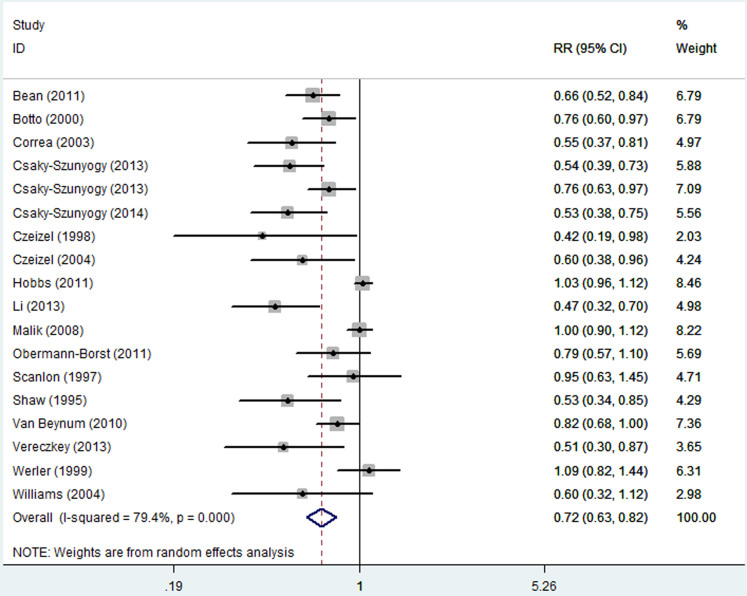
Relative risk (RR) estimates for the association between maternal folate supplementation and the risk of CHDs.Meta-analysis random-effects estimates were used. The sizes of the squares reflect the weighting of the included studies. Bars represent 95% confidence intervals (CIs). The center of the diamond indicates the summary effect; the left and right points of the diamond indicate the 95% confidence interval.